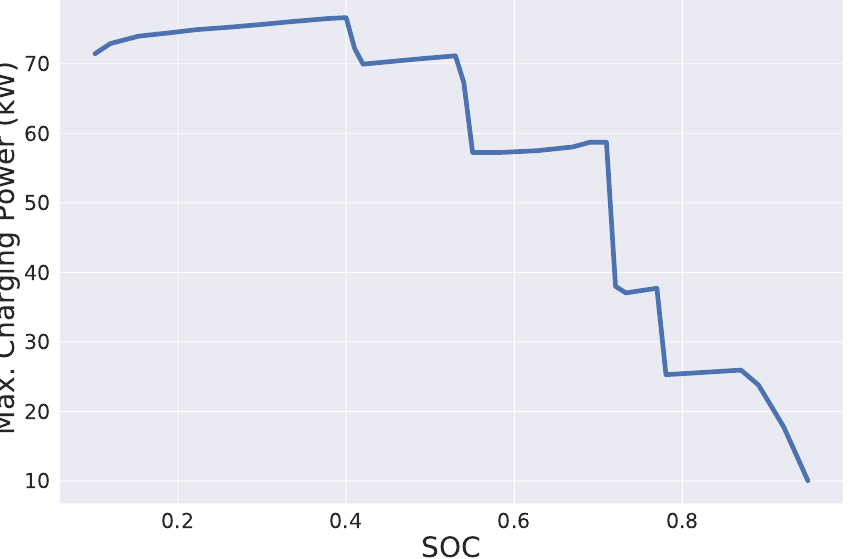
Figure 1. Maximum charging power of a Hyundai Kona Elektro in dependence of the EV’s SOC; data obtained from Fastned